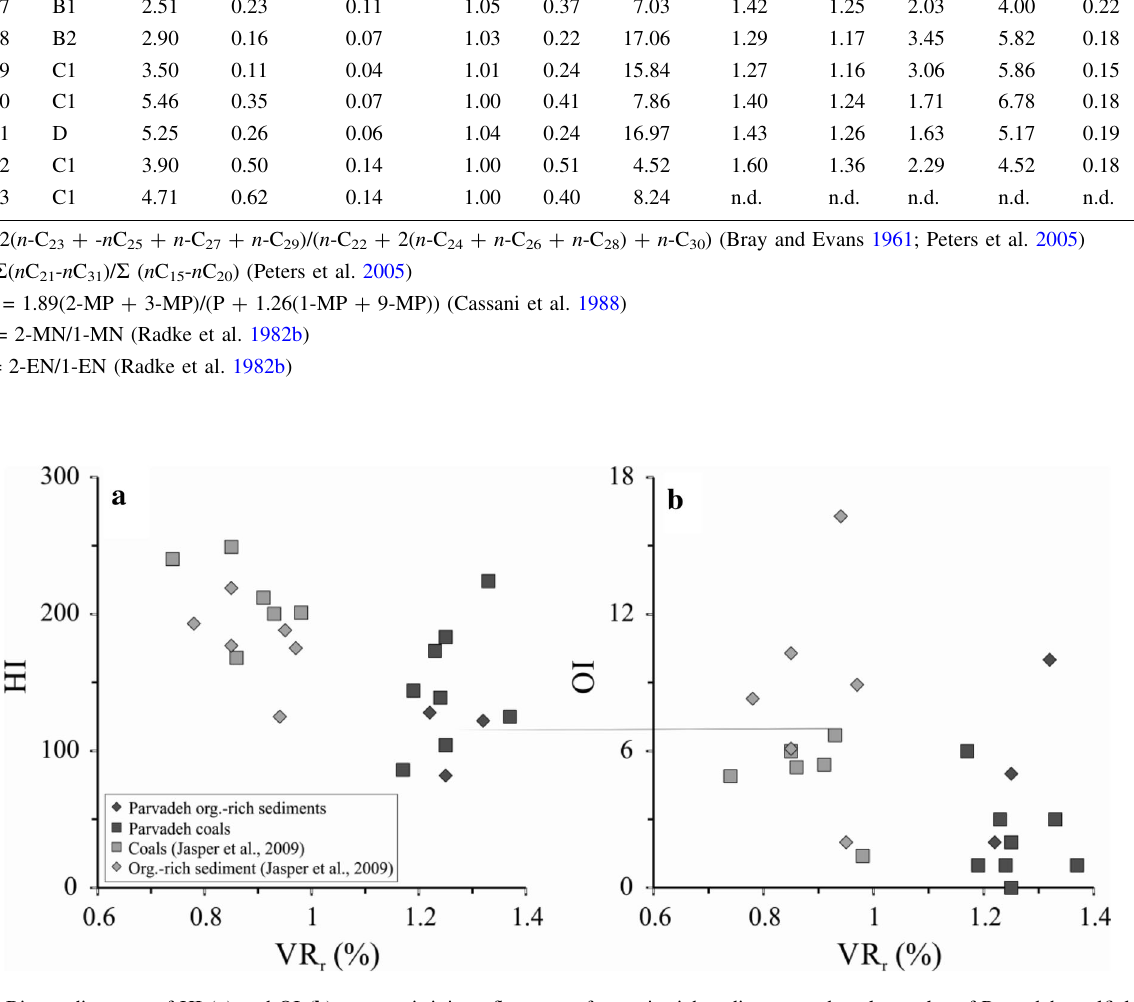
Fig. 6 Binary diagrams of HI ( a ) and OI ( b ) versus vitrinite reflectance of organic-rich sediments and coal samples of Parvadeh coalfields as compared to Carboniferous coal samples from